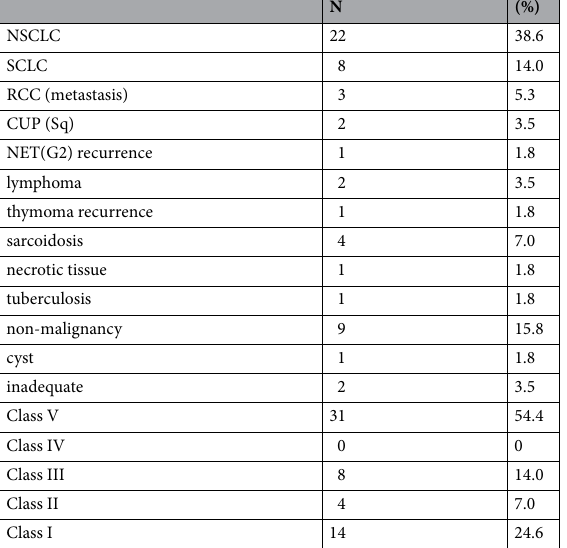
Table 2. Pathological diagnosis. Pathological findings of tissue or cytological specimen obtained using EBUS- TBNA. NSCLC non-small cell lung cancer, SCLC small cell lung cancer, RCC renal cell cancer, CUP cancer of unknown primary, NET neuroendocrine tumor, Sq squamous cell carcinoma, Class I Absence of atypical or abnormal cells, Class II Atypical cytology but no evidence of malignancy, Class III Cytology suggestive of, but not conclusive for malignancy, Class IV Cytology strongly suggestive of malignancy, Class V Cytology conclusive for